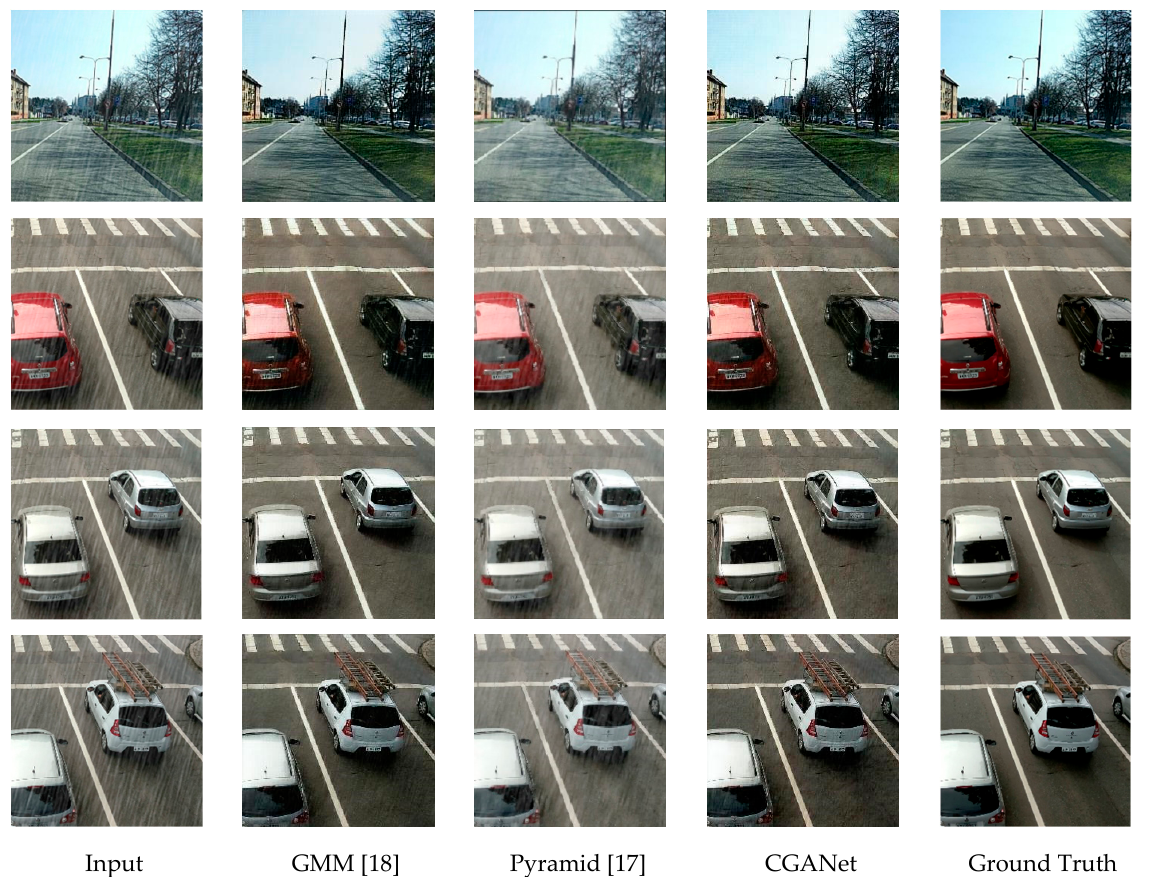
Figure 2. Qualitative comparison between GMM, pyramid networks, and proposed CGANet methods.